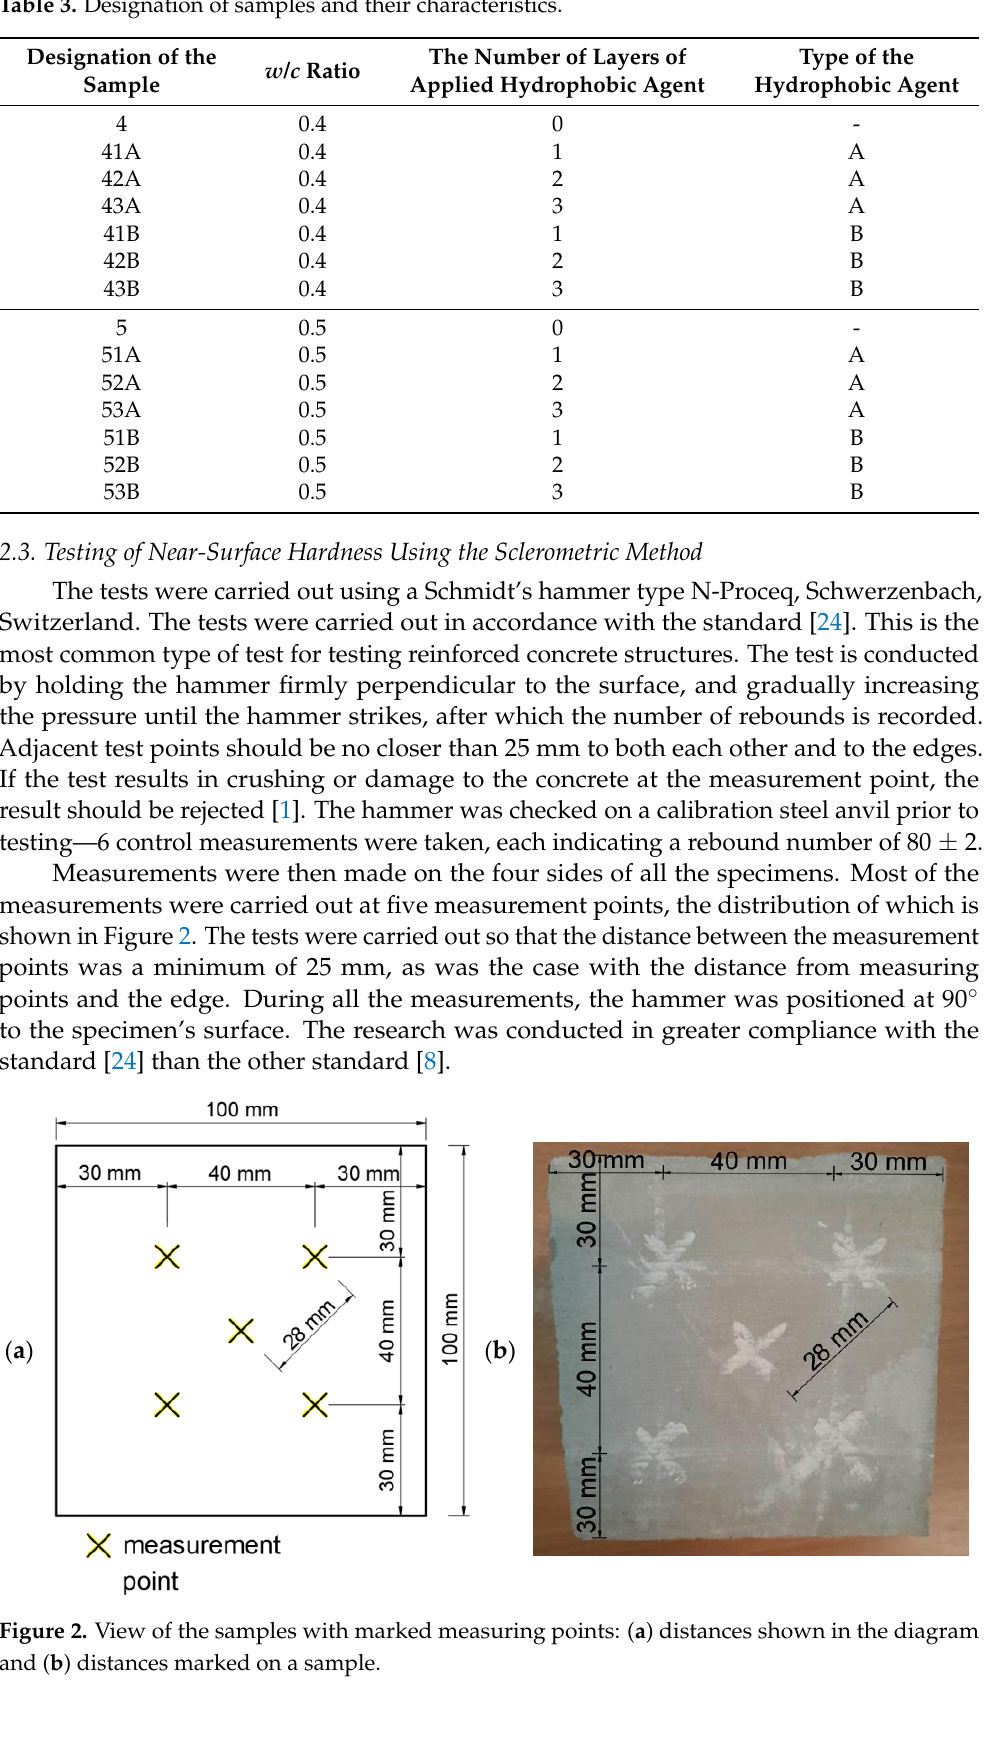
Table 3. Designation of samples and their characteristics.